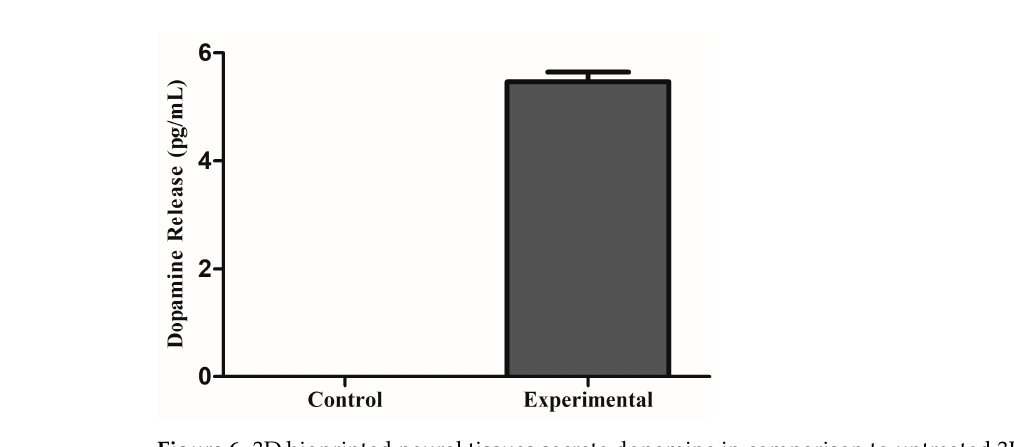
Figure 6 Figure 6. 3D bioprinted neural tissues secrete dopamine in comparison to untreated 3D bioprinted tissues.